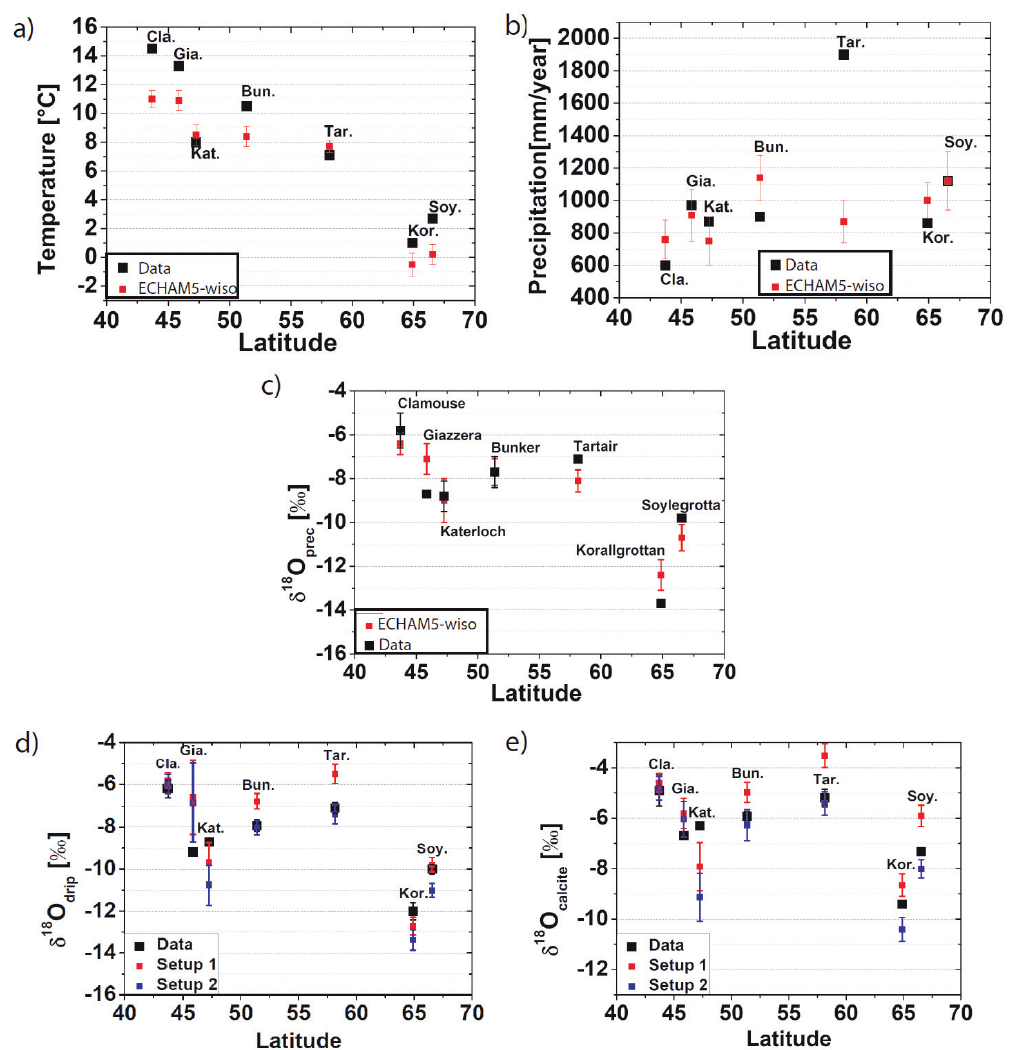
Fig. 1. Comparison of observational data (black) and model results (red: Setup 1 “ECHAM”, blue: Setup 2 “Thornthwaite”) for each cave for (a) mean annual temperature, (b) annual amount of precipitation, (c) δ 18 O prec , (d) δ 18 O drip , and (e) δ 18 O calcite . Drip water δ 18 O values refer to VSMOW and calcite values to